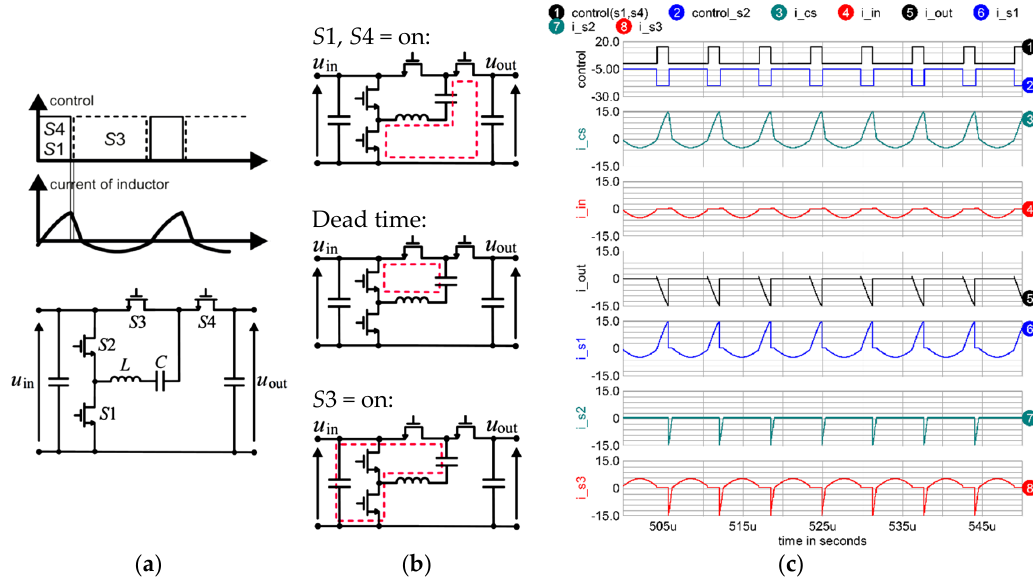
Figure 9. ( a ) Synchronous SCVD and switching pattern P4 with corresponding symbols, ( b ) states in a switching cycle during charging the source by the converter, ( c ) steady-state waveforms during the reverse energy transfer with the use of switching pattern P4 (ICAP/4 simulation results): waveforms reverse energy transfer with the use of switching pattern P4 (ICAP / 4 simulation results): waveforms of of currents (A) and control signals for S 1, S 3 and S 4 (control signal of S 2 = 1). P in = 500 W. Circuit currents(A)andcontrolsignalsfor S 1, S 3and S 4(controlsignalof S 2 = 1). P in = 500W.Circuitparameters parameters as in Table 3. as in Table